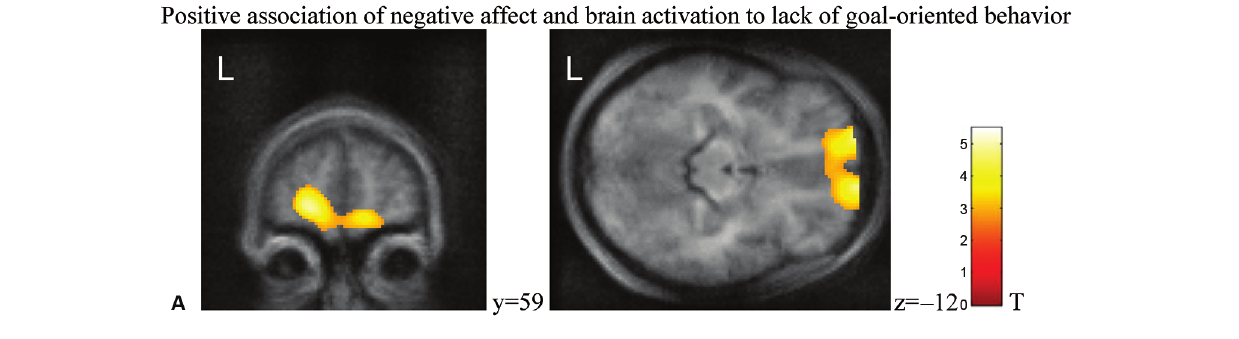
FIGURE 1 | Statistical maps of behavioral prediction of lower individual responsiveness to lack of goal-oriented behavior (threshold for cluster size according to p < 0.05 corrected) . Bilateral clusters revealed a negative